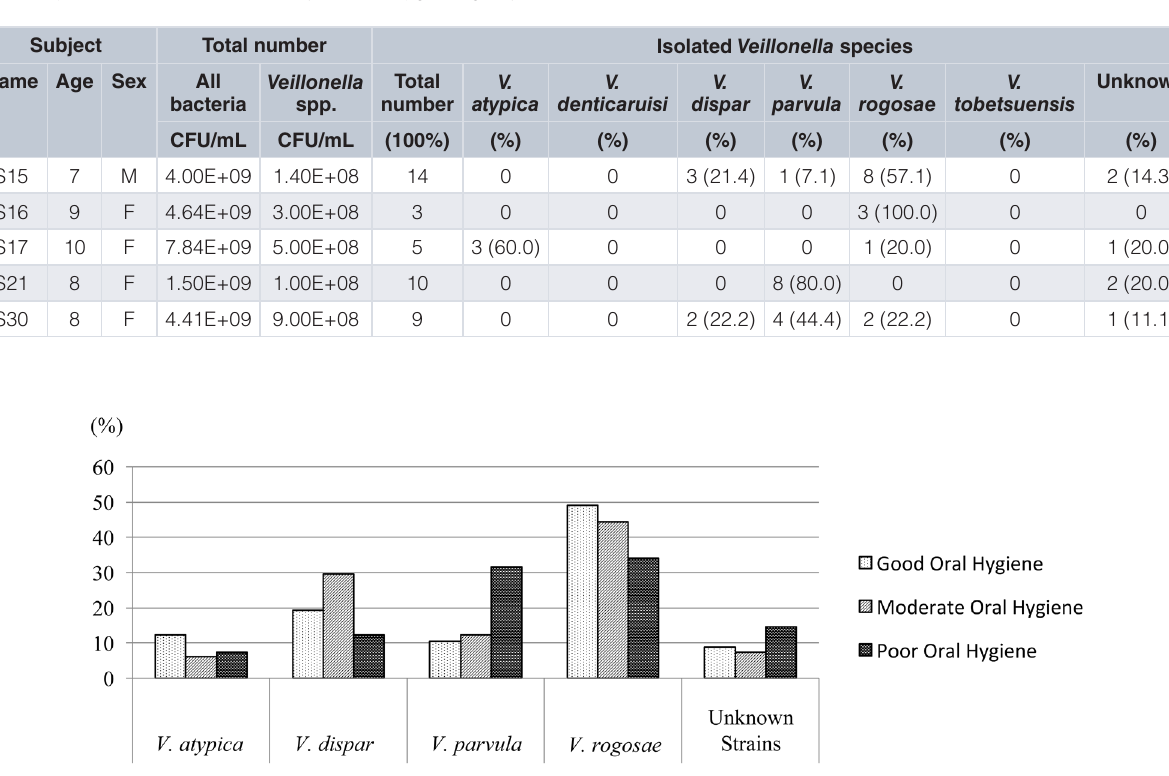
species and the 10 unknown strains is shown in the Figure